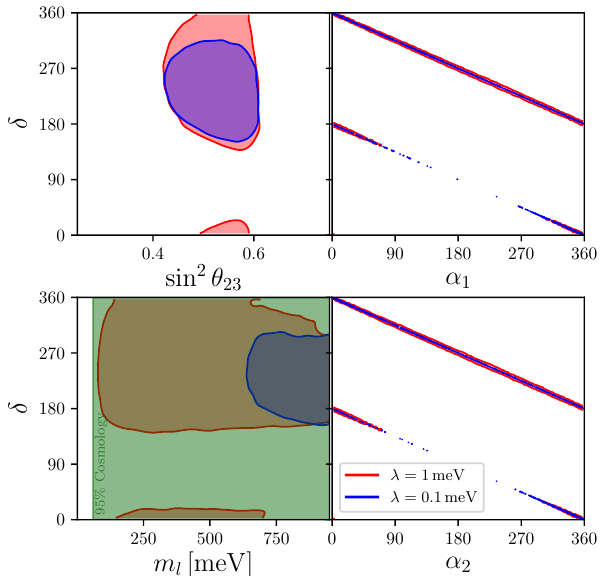
Figure 6 . Allowed 3 (cid:27) regions in the case of the \excluded" F 1 -NO texture when the texture zeroes are only